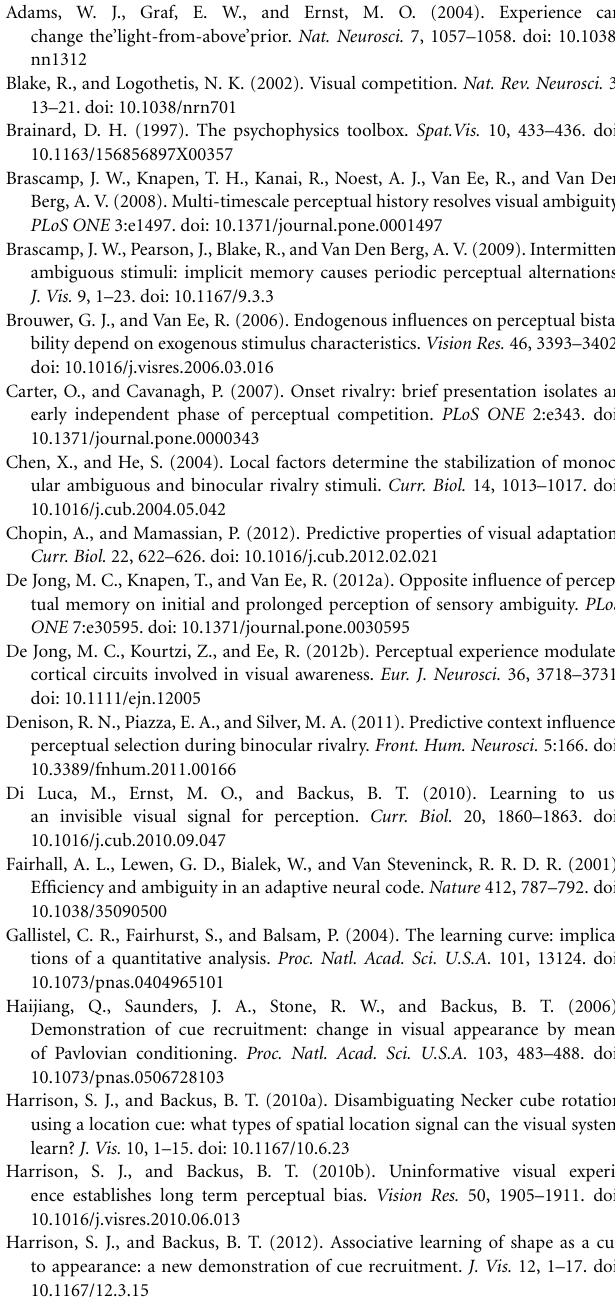
Figure S3 | Time courses of perceptual bias for individual participants in experiment 2. (A) Full learners—participants who expressed biases in the trained direction at both locations. (B) Partial learners—participants who expressed a bias in the trained direction at only one location. For clarity, raw data was boxcar filtered with a window of 8 trials for intermittent